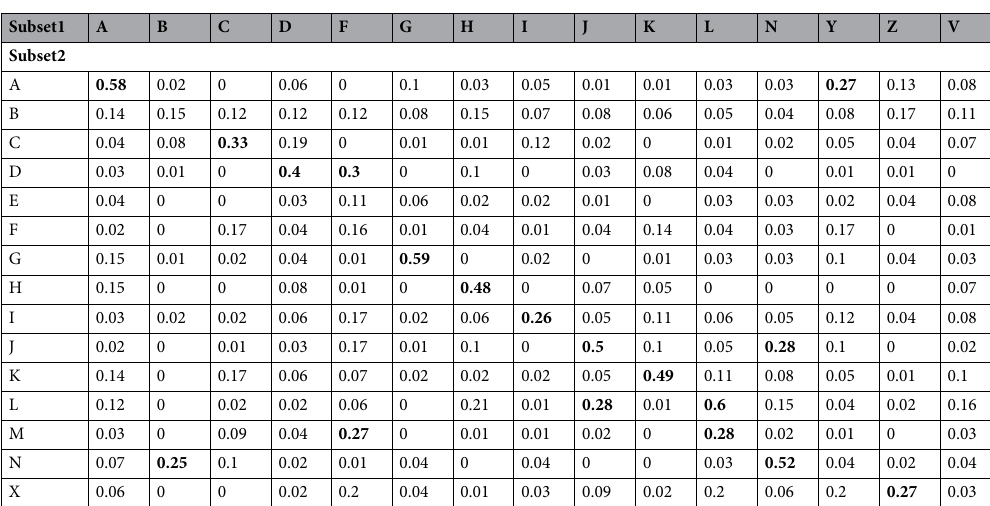
Table 4. Dice similarity coefficients of the two ICAs, run separately for the two runs. Labels of subset 1 are displayed in rows, while labels of subset 2 are columns. Dice similarity coefficients over 0.25 are highlighted in